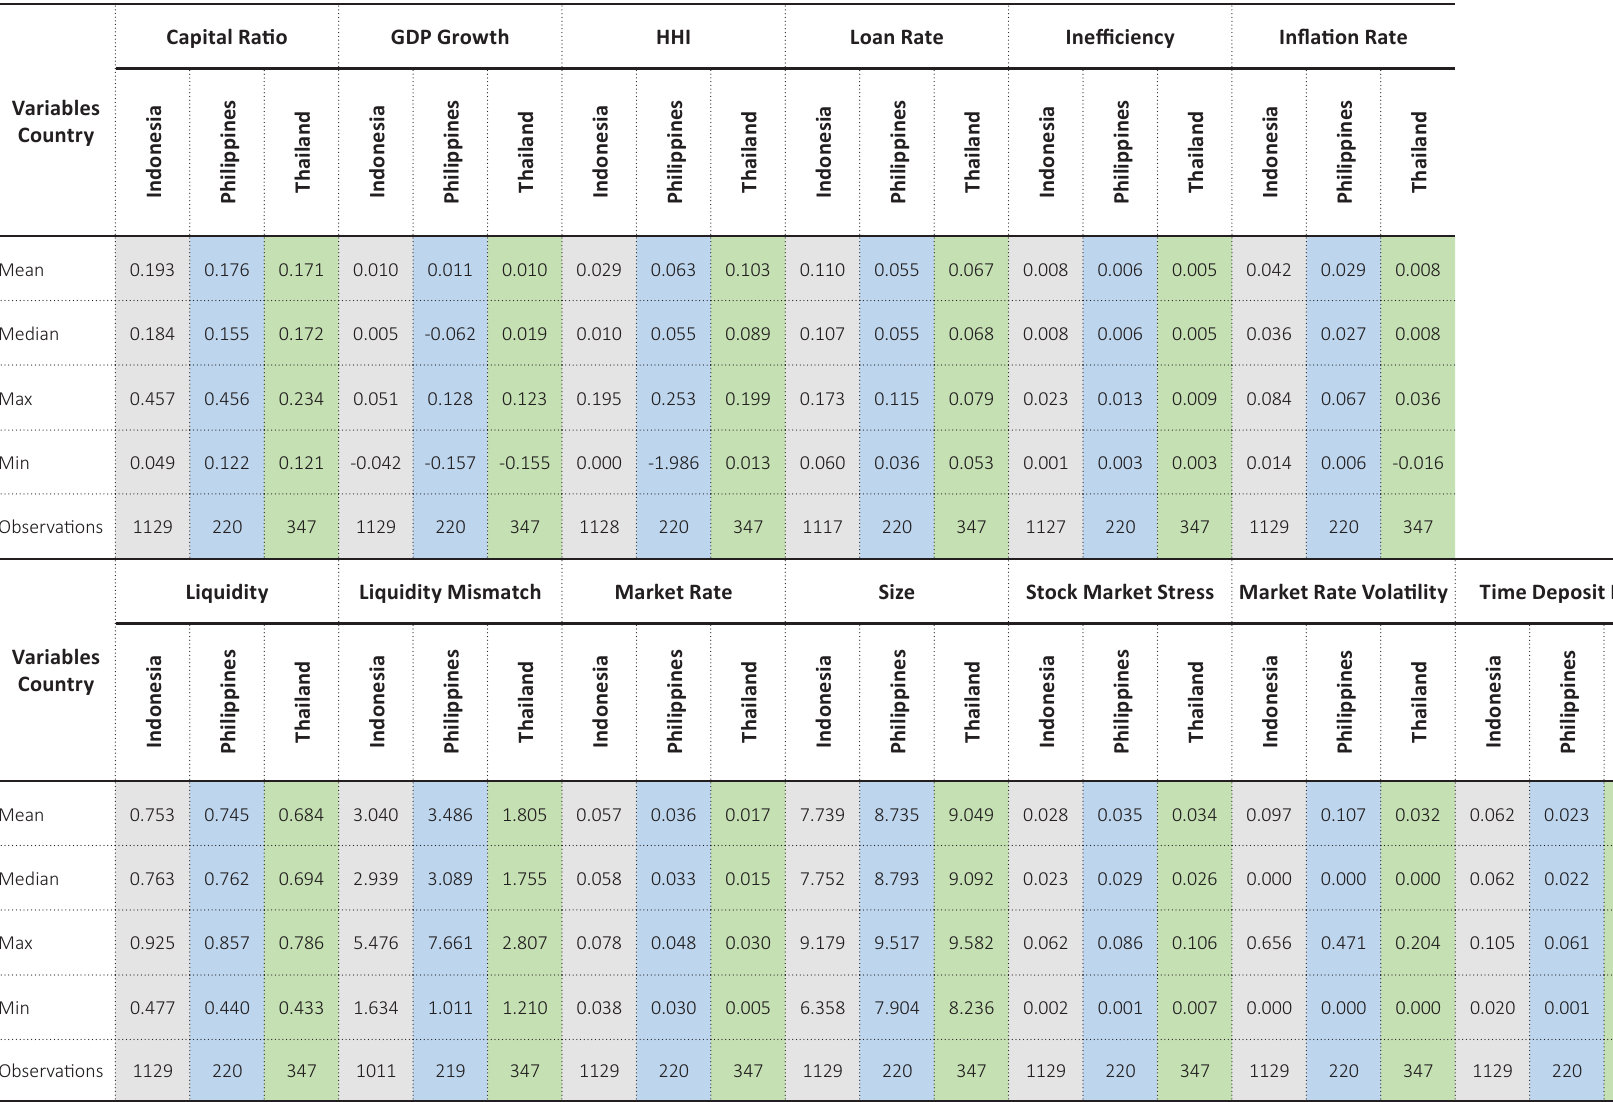
Table A2. Descriptive statistics from equation 3 (Time Deposit